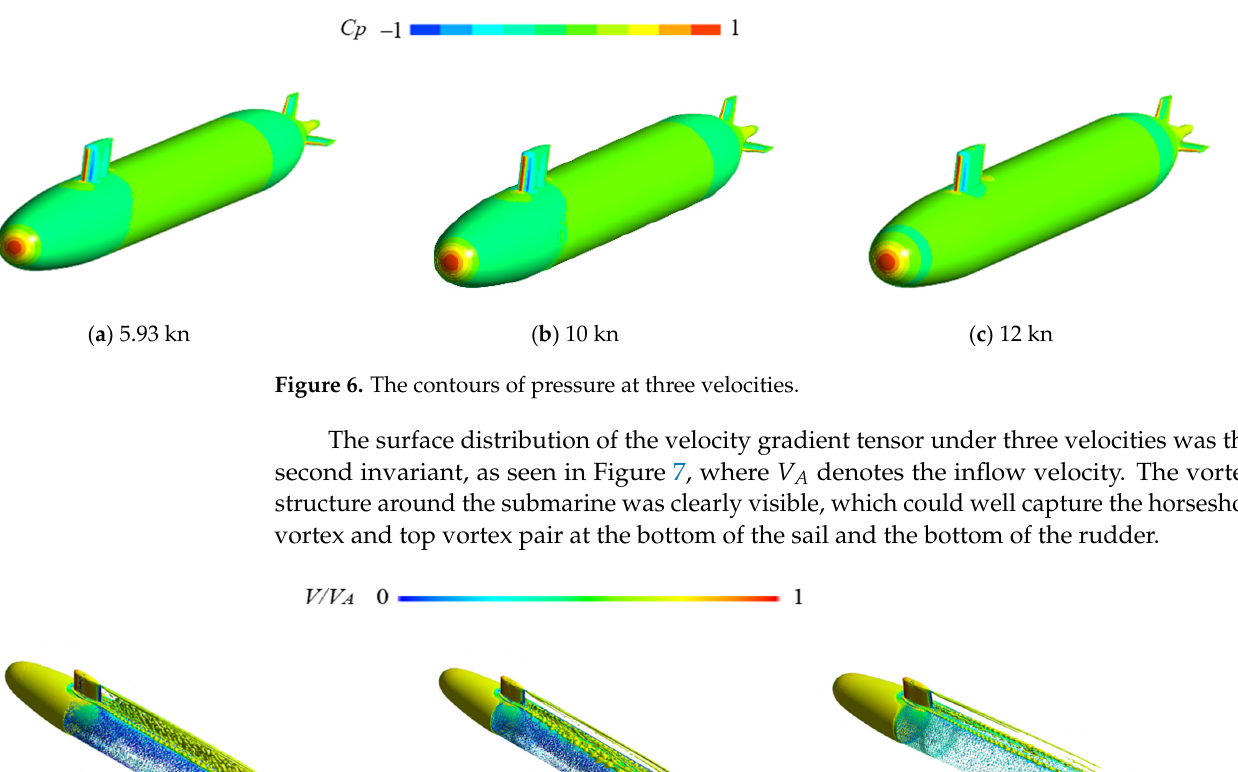
Figure 5. C f along the upper meridian line.